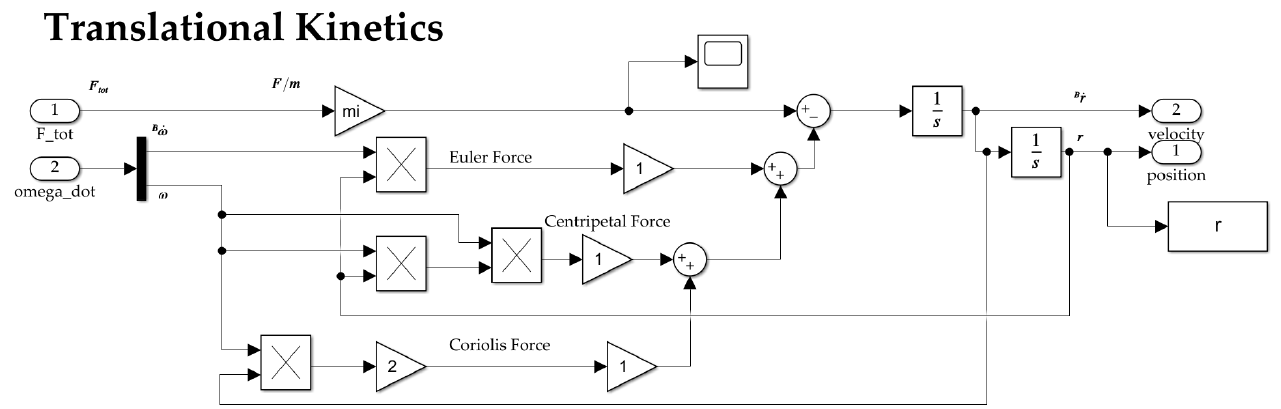
Figure A10. MatLab model with complete detailed display of the kranslational Kinetics Simulink subsystem.